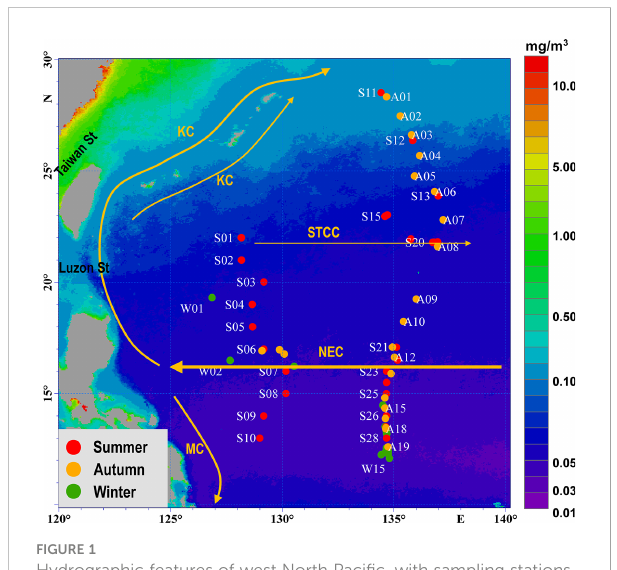
FIGURE 1 Hydrographic features of west North Paci fi c, with sampling stations of ichthyoplankton in oligotrophic water of the Philippine Sea. Currents: KC (Kuroshio Current), MC (Mindanao Current), NEC (North Equatorial Current), STCC (Subtropical Countercurrent). Stations sampled in summer are shown in red, stations sampled in autumn are shown in orange, and stations sampled in winter are shown in green. The annual chlorophyll data in the background was downloaded from the E.U. Copernicus Marine